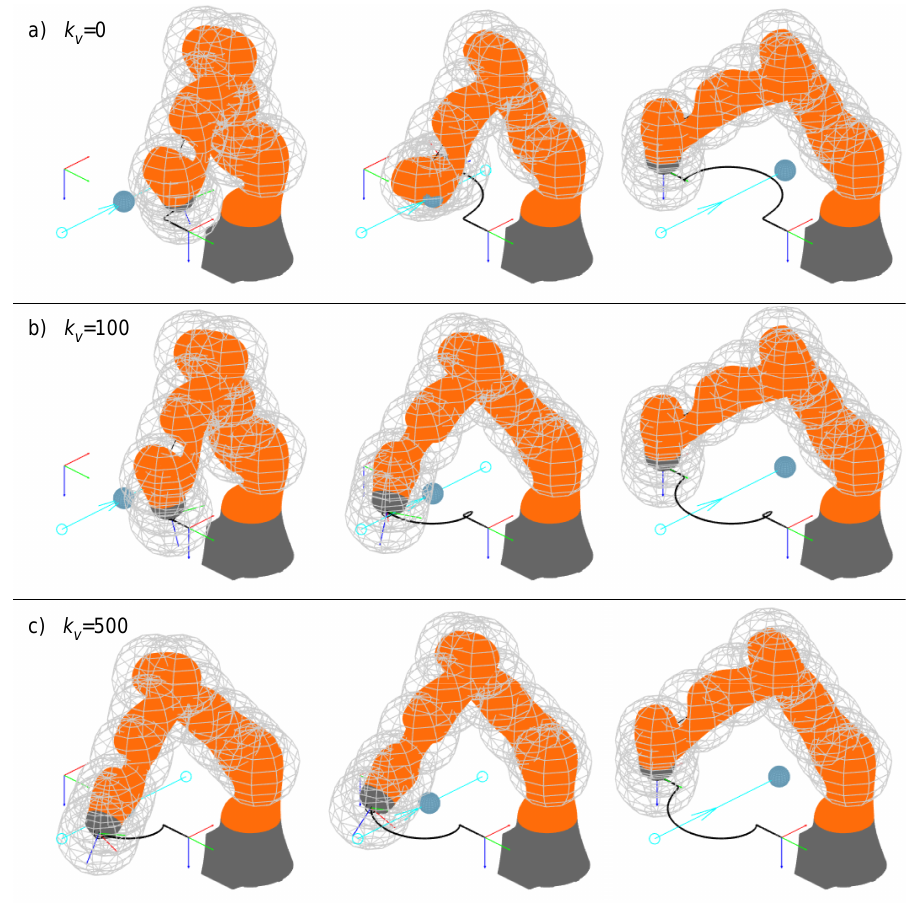
Figure 19. Example 5: response of the control law to a moving obstacle with different values of k v